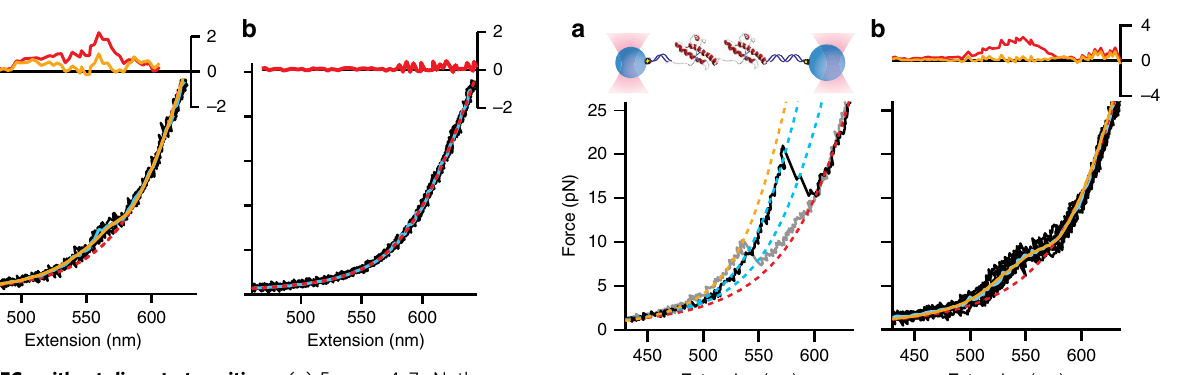
NATURE COMMUNICATIONS|7:12058|DOI: